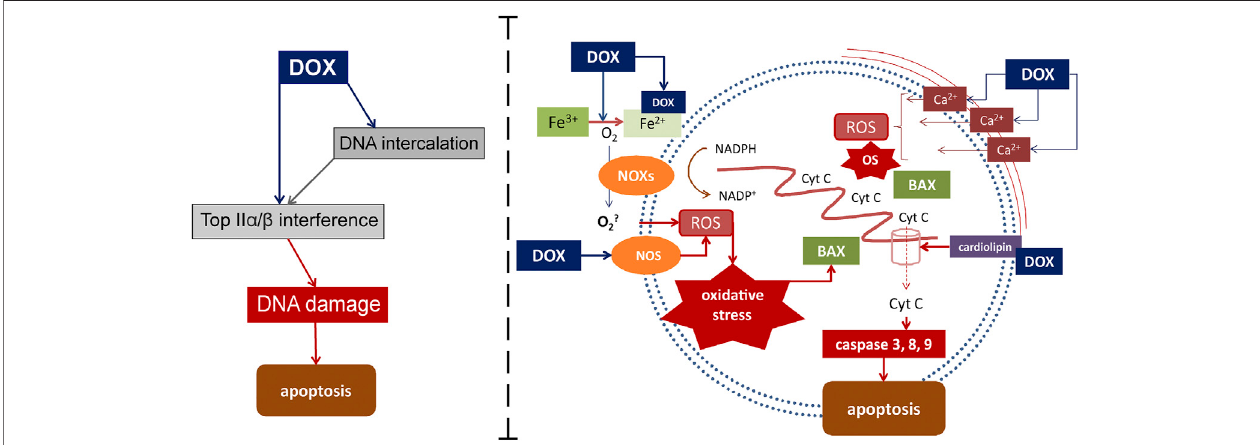
FIGURE1| MechanismsofDOX-inducedcardiomyocytedamage.DOXtargetsTop2 α / β .ThisleadstothesuppressionoftheformationoftheTop2-DNAcleavage complex, followed by the transcription arrest, which then results in the DNA damage and cell death. DOX also mediates apoptosis through interaction with Fe with subsequent active oxygen releasing and oxidative stressactivation. Another way for oxidativestressactivation isDOX-inducedincreasing ofcalcium ions releasing from the sarcoplasmic reticulum. Binding to cardiolipin DOX leads to mitochondrial dysfunction. Active cytochrome C releasing from mitochondrias to cytoplasm through the pores activates inner ways of apoptosis. BAX, Bcl-2-associated X protein; Cyt C-cytochrome C; DOX-doxorubicin; NOS-nitric oxide synthases; eNOS- endothelial NOS; NOXs-nicotinamide adenine dinucleotide phosphate oxidases; NADPH-nicotinamide adenine dinucleotide phosphate; ROS-reactive oxygen species.